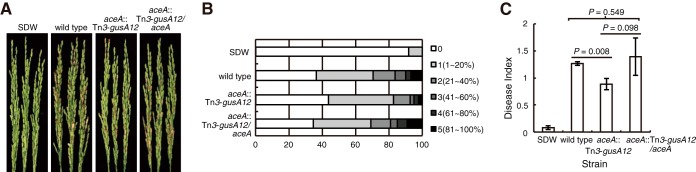
The isocitrate lyase-deficient mutant was less virulent in rice panicles than the wild-type strain. (A) The wild-type strain produced severe symptoms in the panicles, including discoloration and empty heads of grain. Panicles inoculated with the isocitrate lyase-deficient mutant displayed milder symptoms. SDW, sterile distilled water. (B and C) Disease degree (B) and index (C) were evaluated as previously described (Materials and Methods). Pathogenicity assays were repeated three times in triplicate.